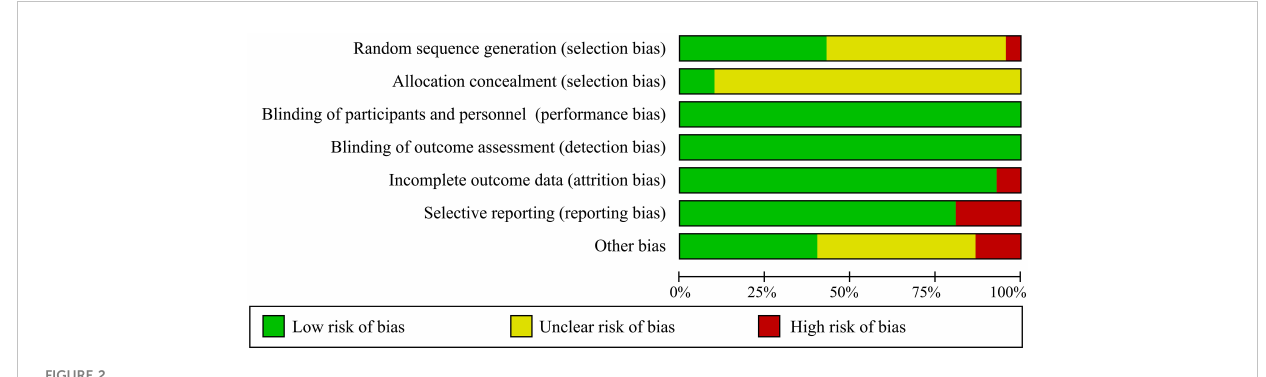
FIGURE 2 Risk of bias graph of methodological bias.